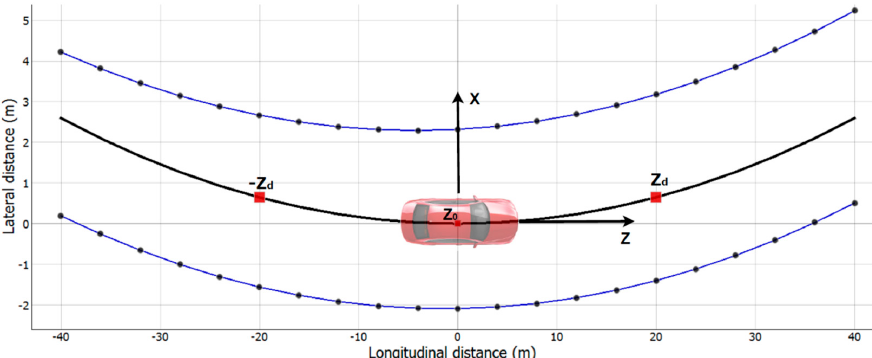
Figure 10. Example lane markers model with destination point Z d . The black center line is the curve for the vehicle to follow. using Equation (5).